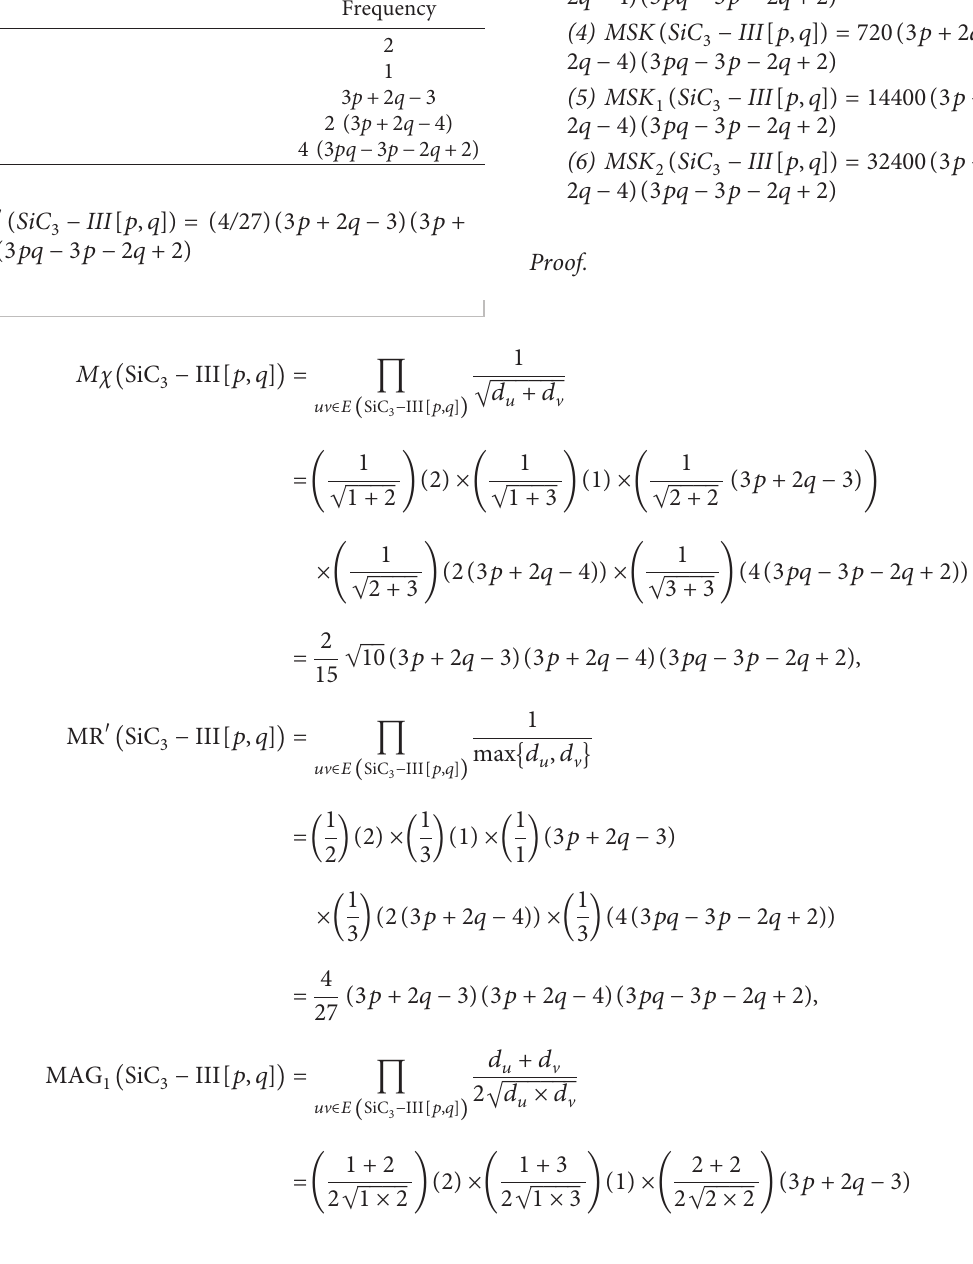
Table 4: Partition of E ( SiC